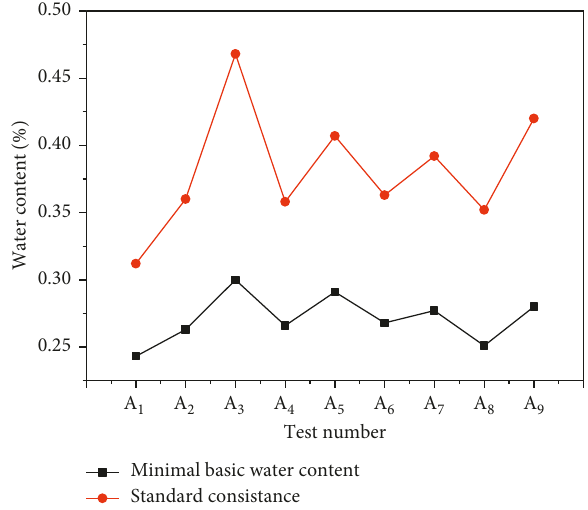
Figure 13: Water requirement and standard consistence as a function of the test number.